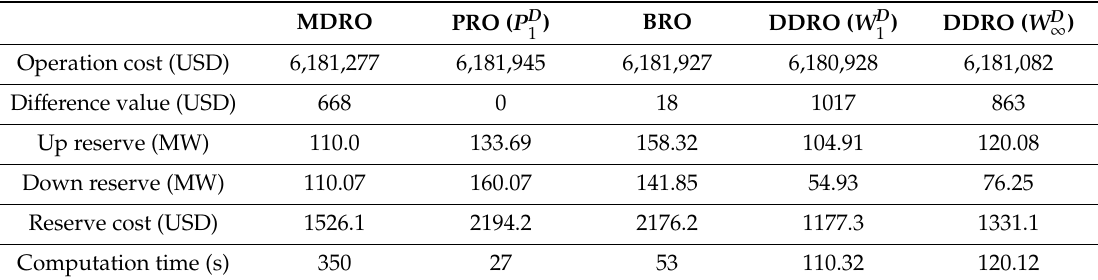
Table 4. Comparison of di ff erent optimization